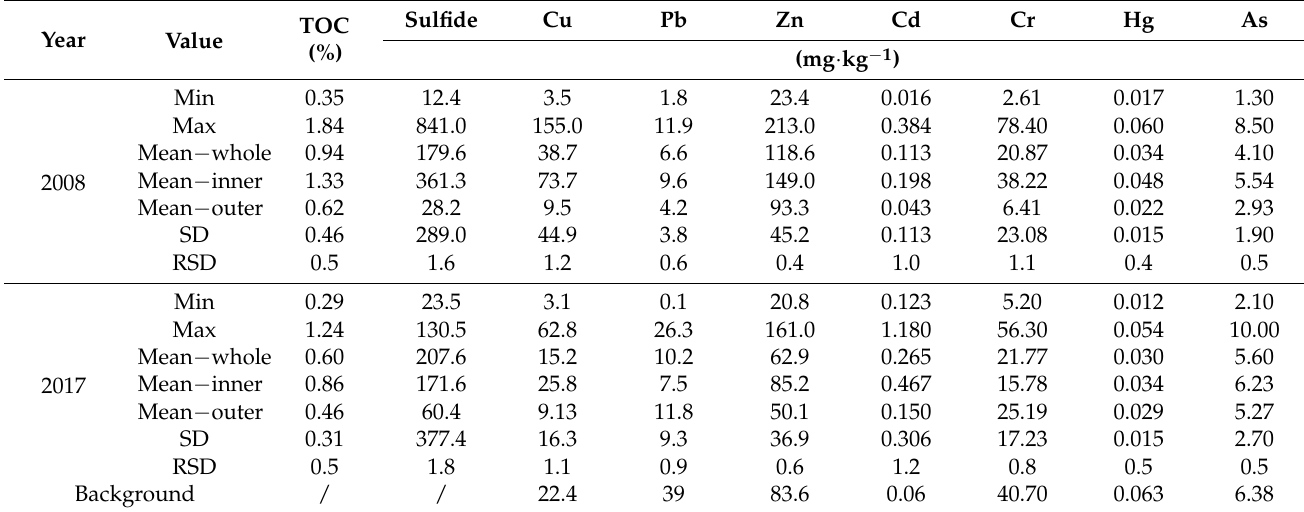
Table 1. Heavy metal concentrations in the surface sediment of Weitou